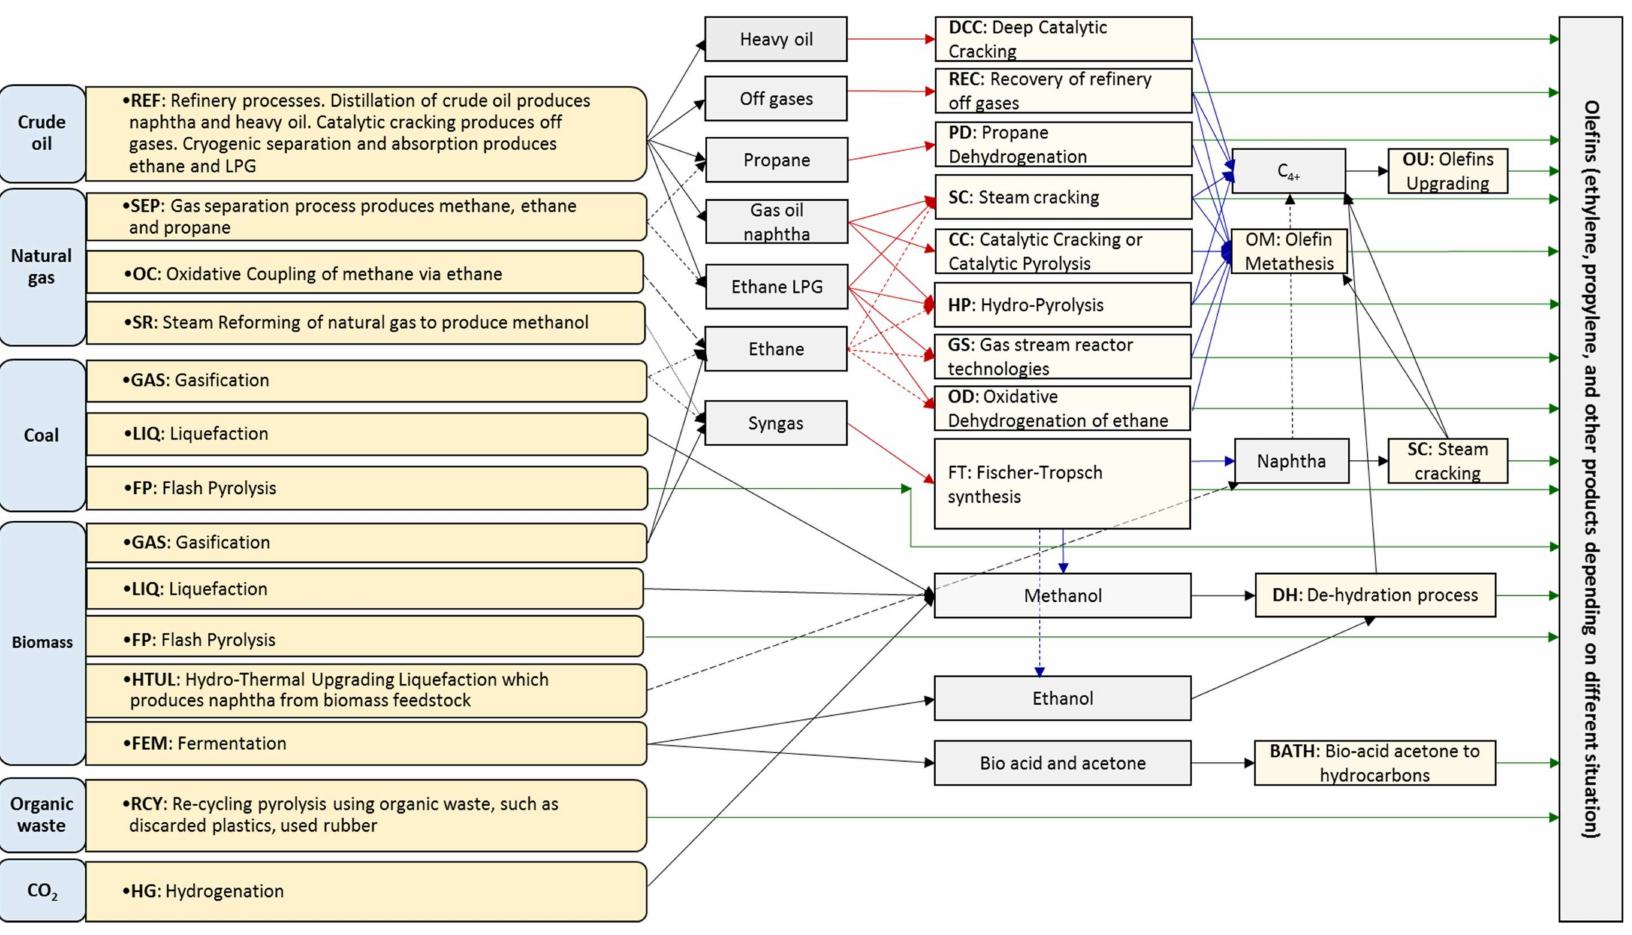
Figure 1. Different technologies for olefin production, reproduced from